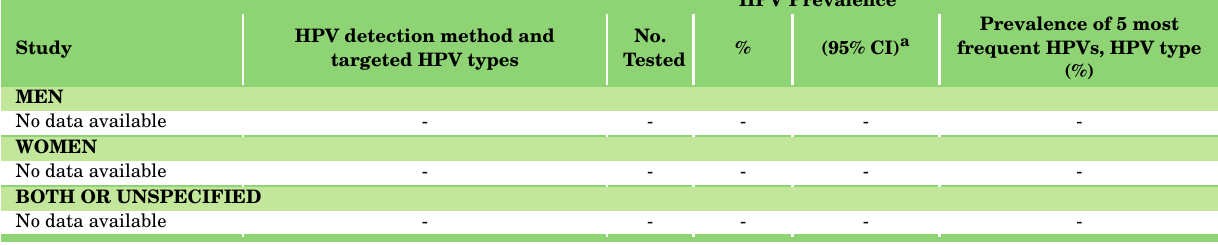
Table 37: Studies on HPV prevalence among cases of oropharyngeal cancer in India